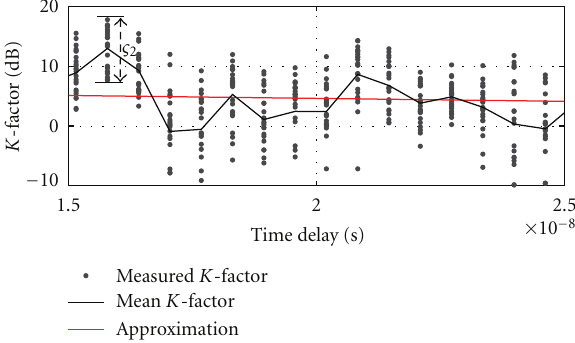
Figure 5: Measured Rice factor K ( τ ) of all the measurements’ sets for the case with two